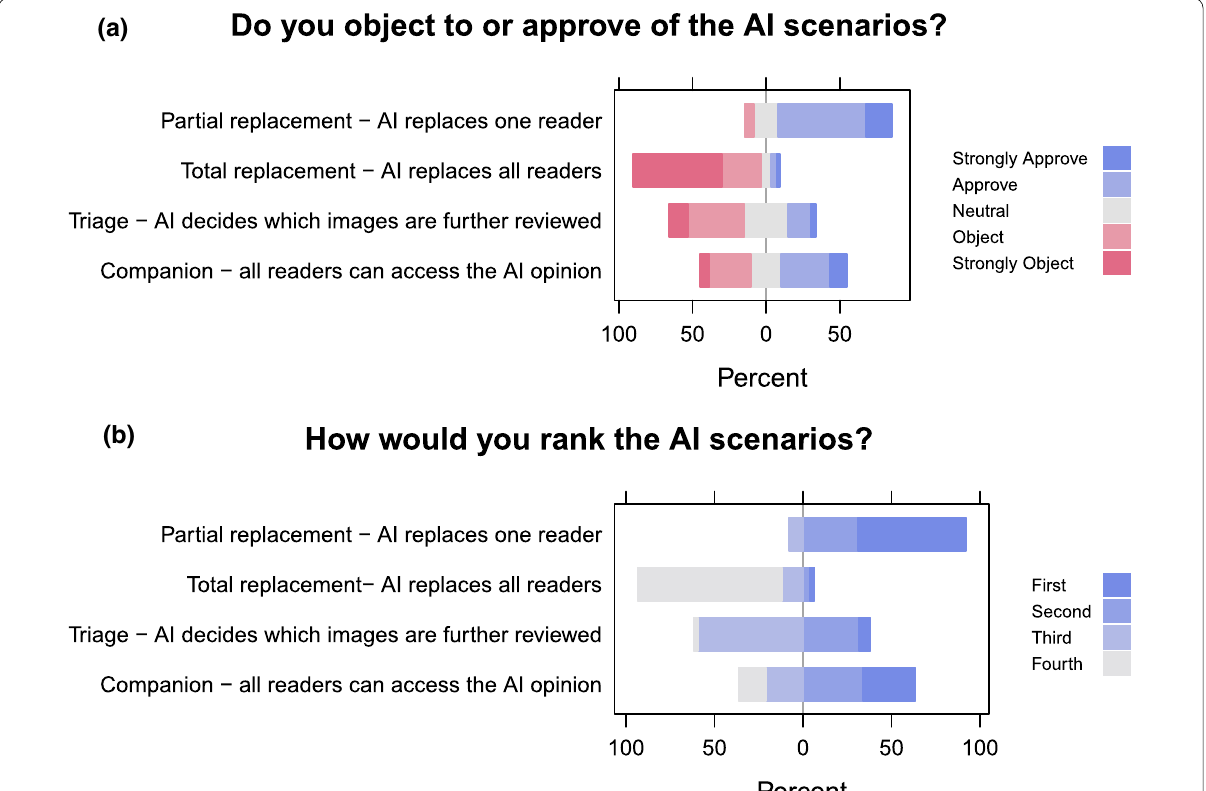
Fig. 1 How should AI be implemented? a Participants were presented with four scenarios on the use of AI in breast screening and were asked to select the options that most closely reflect their views. b Participants were asked to rank the four AI scenarios in order of preference